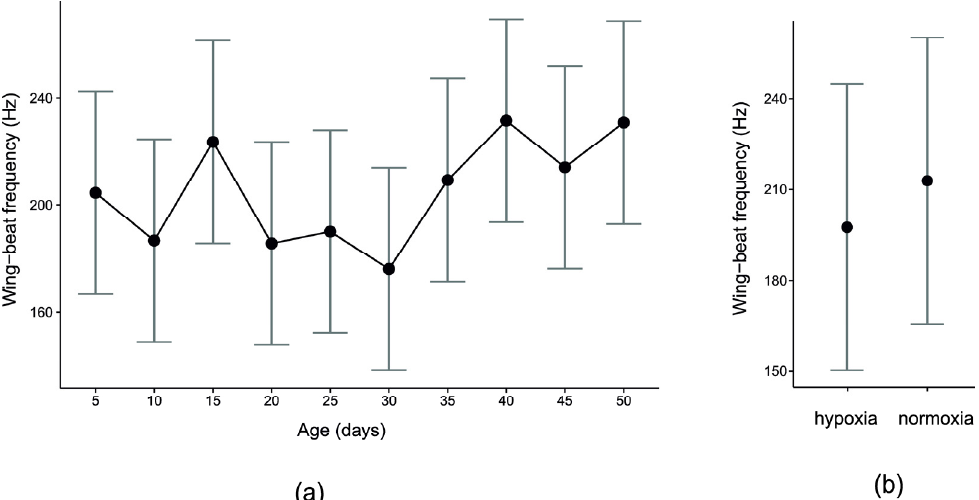
Figure 2. Males of Drosophila melanogaster showed significant differences in flight performance among age classes, but these changes did not show any consistent age pattern ( a ). Flies achieved lower flight performance in hypoxic (10% O 2 ) than in normoxic (21% O 2 ) conditions ( b ). Flight performance was measured as the maximum wing-beat frequency of tethered flies (see Figure 1a for technical measurement details). The means (95% CIs) were estimated with a general linear mixed model.